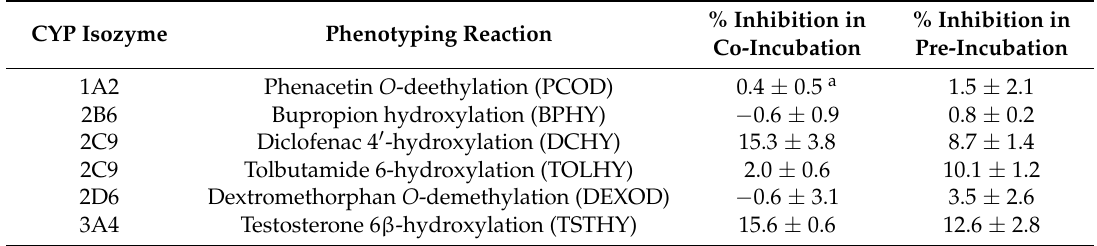
Table 4. Cytochrome P450 (CYP) inhibition effects of SKN in human liver microsomes. CYP Isozyme